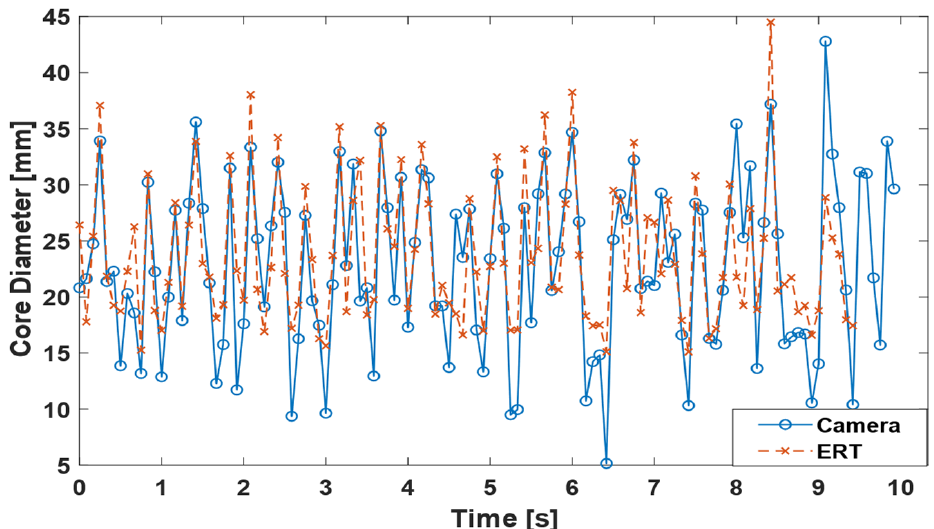
Figure 14. Time series comparison of the diameter between the ERT and the Camera at the point of maximum cross-correlation between the signals.